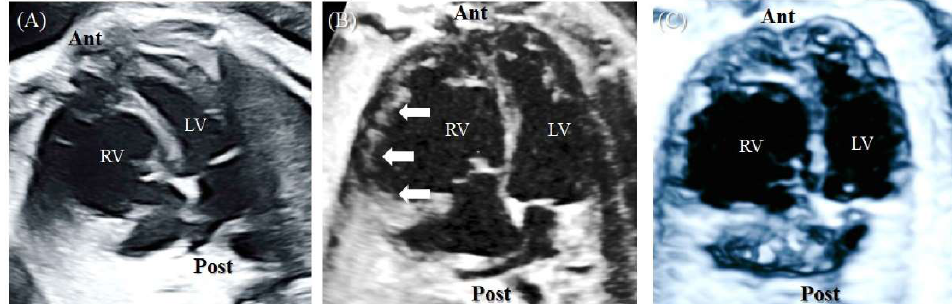
Figure 2. At 35 +2 weeks GA, fetal echocardiography was performed. ( A ) B-mode image of four- chamber view. The globular RV persisted. ( B ) The cardiac image with STIC technology. The outpouching ventricular wall (arrowhead) was observed and had a thickness and layering similar to those of the rest of the ventricle. ( C ) Video still image of the 4D video, which was acquired by surface-rendering mode of the STIC volume in grayscale. Ant, anterior; Lt, left; LV, left ventricle; Post, posterior; Rt, right; RV, right ventricle; STIC, spatiotemporal image correlation. Since the new ultrasound device, a Voluson E10 with an eM6C G2 metrix probe (GE Healthcare Korea, Seoul, Korea), had been introduced to our hospital, quantitative assessment of the fetal heart using Fetal HQ was performed. First, in the four-chamber view (4CV) global size and shape, the global sphericity index (GSI) was measured. B-mode images were used for the previous two scans, and speckle-tracking analysis was used for the latter two scans (Figure 3 and Table 1).